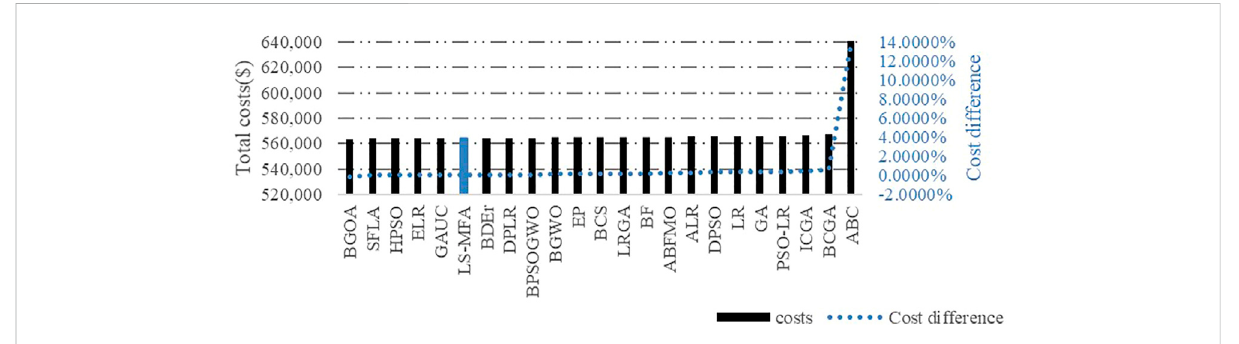
FIGURE 8 Comparison of total cost with reported optimization techniques for 10-unit system.